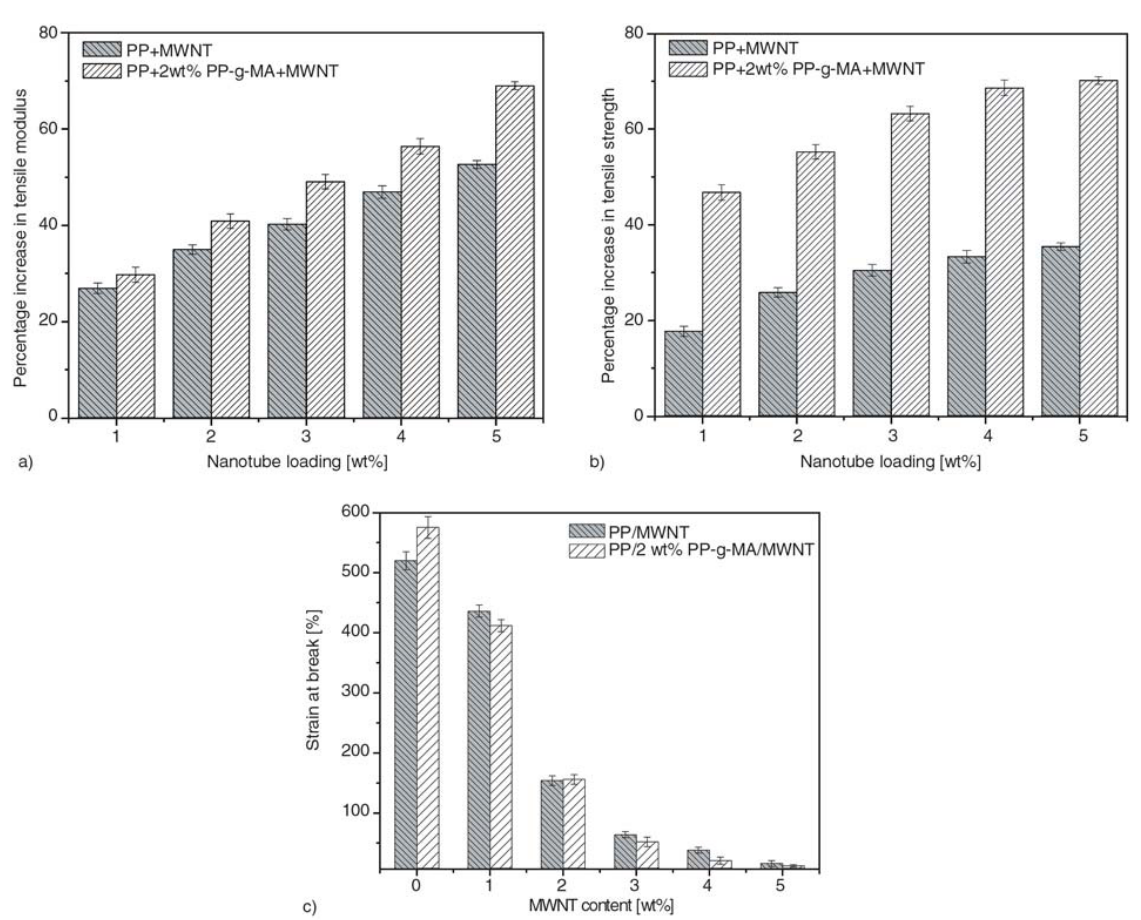
Figure 45. Percentage increase in tensile modulus with respect to PP and PP-g-MA as a function of MWCNTs content for the PP/MWCNTs and PP/MWCNTs/2 wt % PP-g-MA composites (a). Percentage increase in tensile strength with respect to PP and PP-g-MA as a function of MWCNTs content for the PP/MWCNTs and PP/MWCNTs/2 wt % PP-g-MA composites (b). Variation of percentage strain at break with MWCNTs content for the PP/MWCNTs and PP/MWCNTs/2 wt % PP-g-MA composites (c). Reproduced with permission from ref. [104].